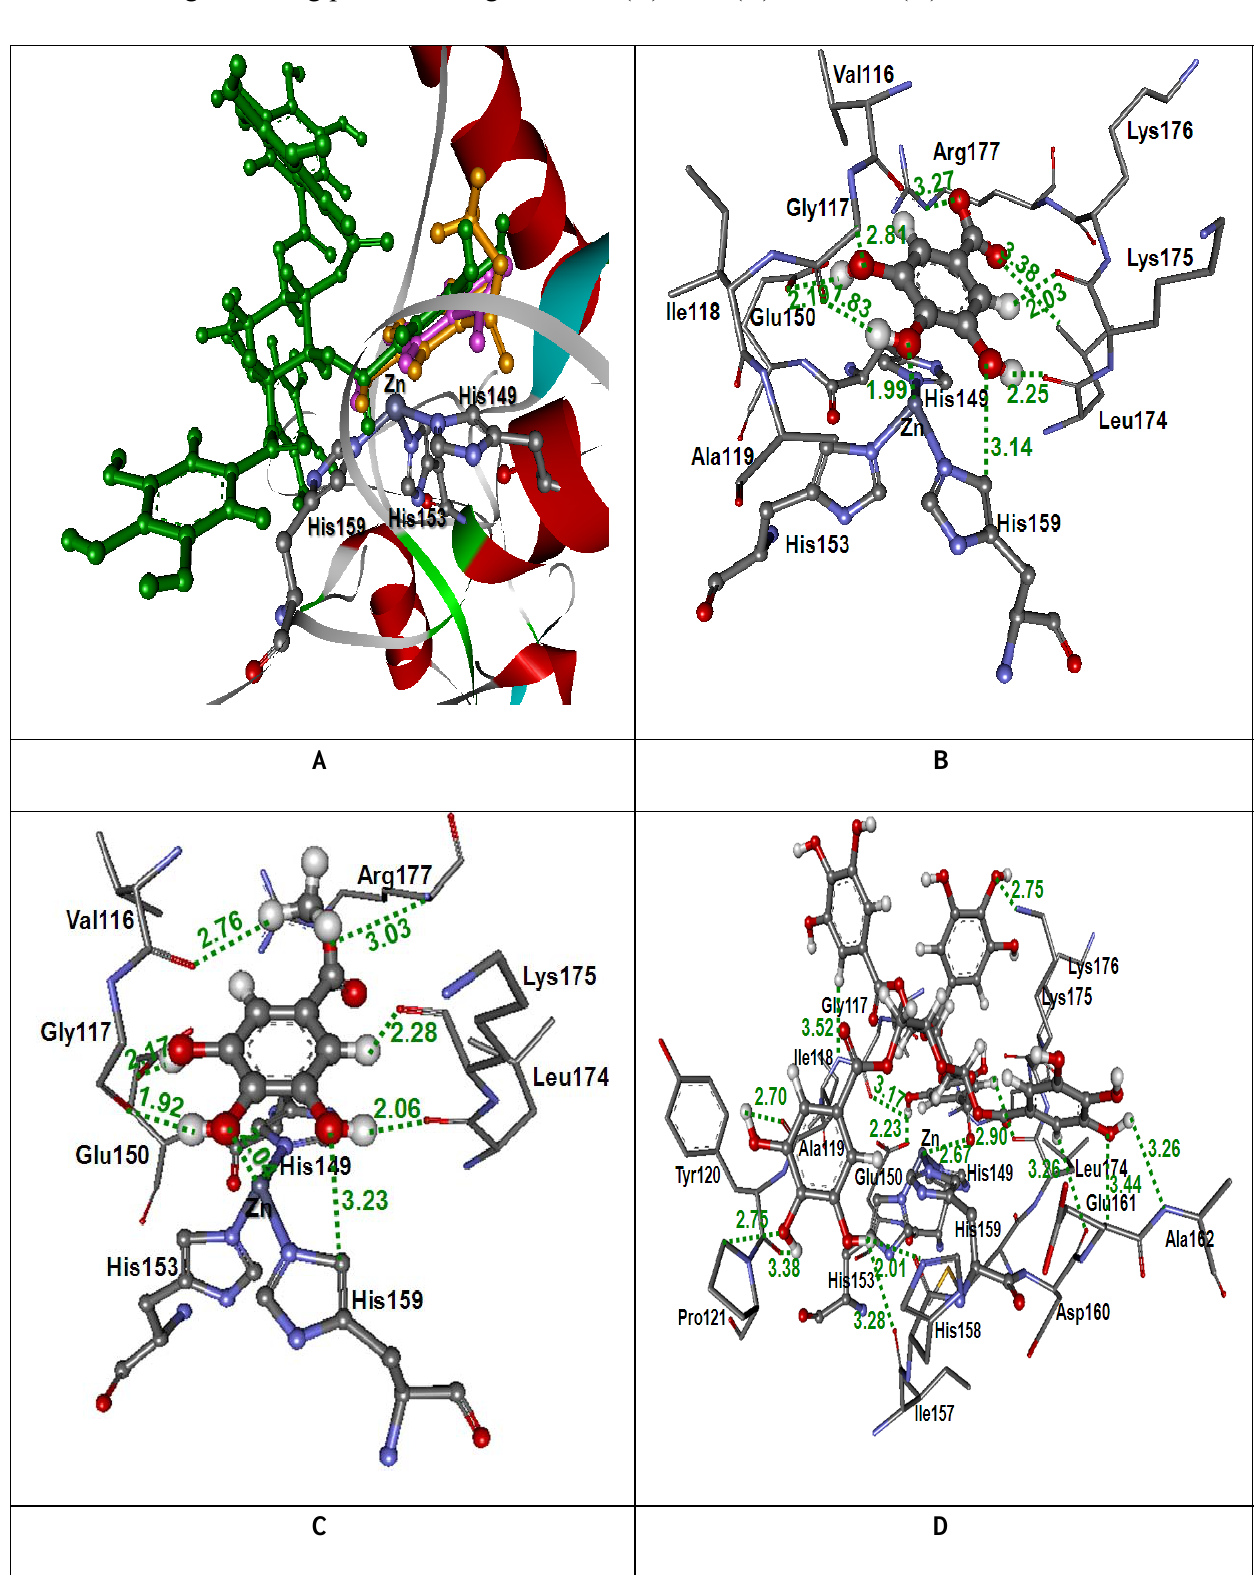
Figure 4. (A) Docked conformation of ligand structures in the binding site of kaouthiagin (GA: Pink, MG: Orange and PGG: Green). (B–D) Distances (in Å) between residues in the kaouthiagin binding pocket and ligands: GA (B), MG (C) and PGG